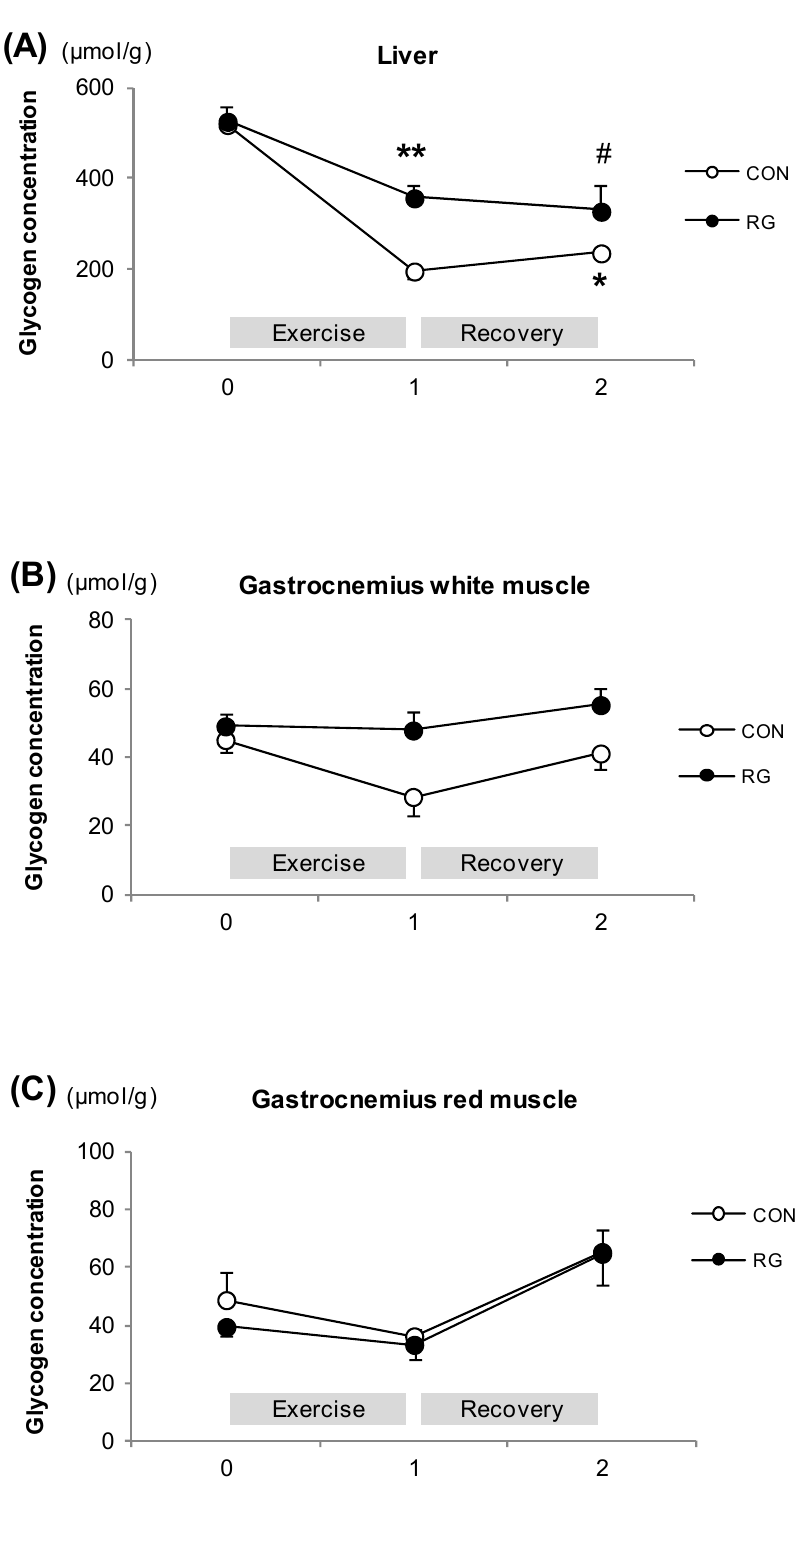
Figure 3. The change in glycogen concentrations during exercise and after exercise for one hour. ( A ): Liver; ( B ): Gastrocnemius-white muscle; ( C ): Gastrocnemius-red muscle at rest, after exercise, and recovery in the CON and RG groups. Values are represented as means ± standard error ( n = 14). # vs. Rest in RG, p < 0.01; ** vs. Rest in RG, p < 0.01; * vs. Rest in CON, p < 0.05 (two-way analysis of variance group effect ***); CON: no treatment with training; RG: RG treatment with